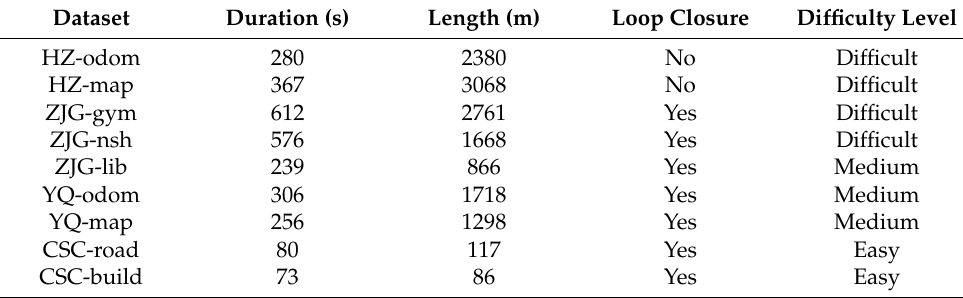
Table 1. Dataset detail.